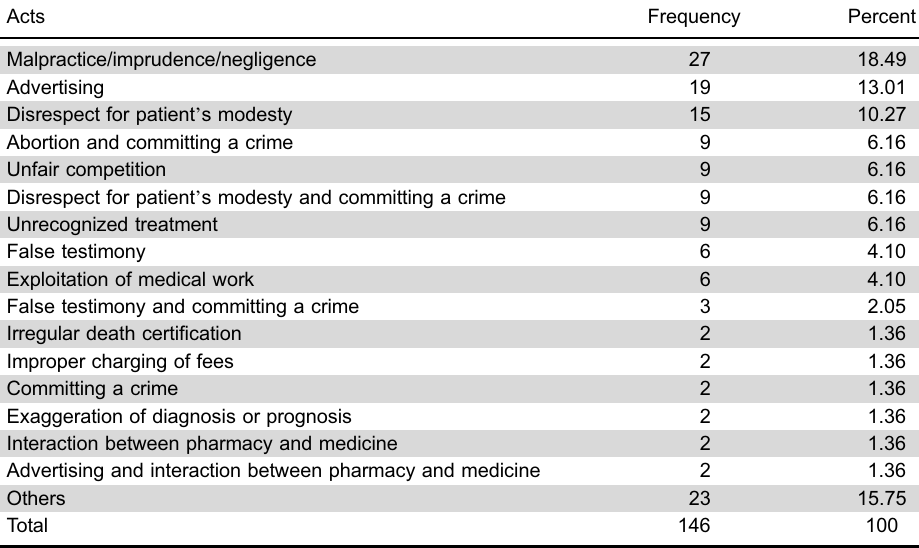
Data are reported as frequency and percent. Table 6. Actions most often